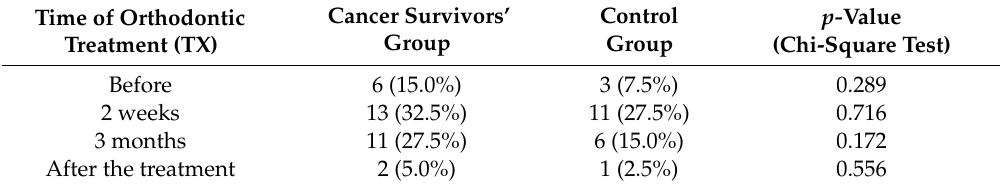
Table 8. OHIP-14 simple count—the number of patients with oral health impacts. Time of Orthodontic Treatment